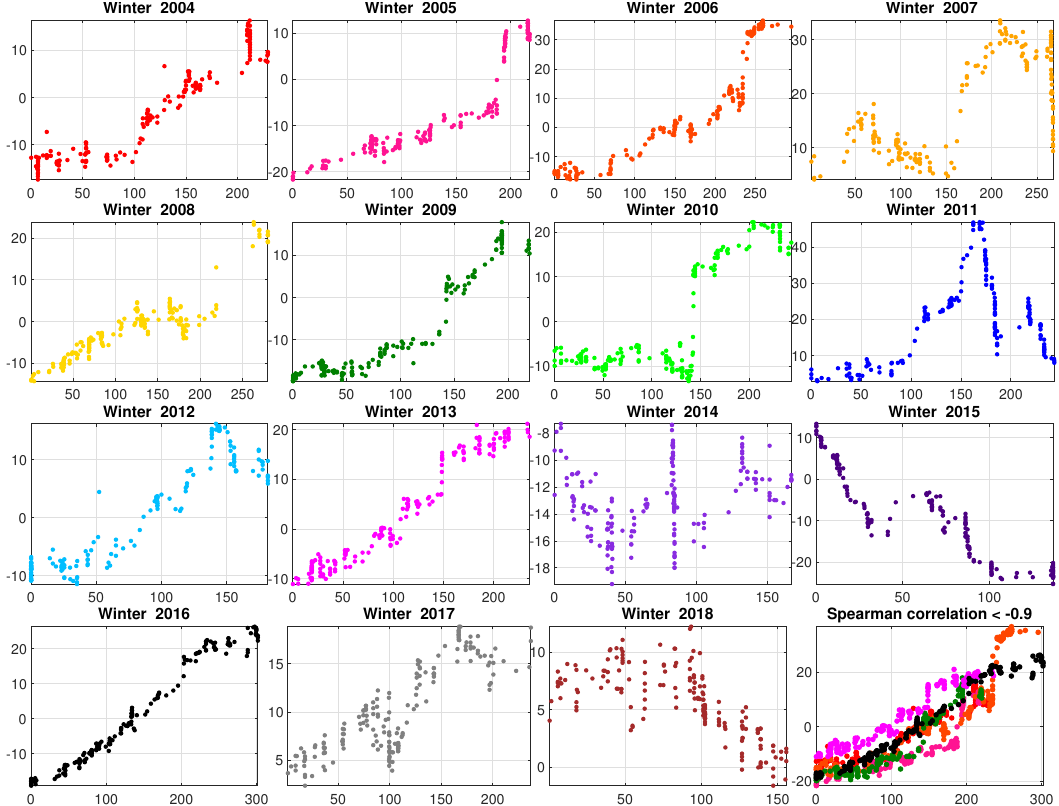
Figure 21. Scatterplots for the winter seasons. On the OY axis, the detrended groundwater levels and on the OX axis the cumulative sums of precipitation are presented. The bottom right plot presents the winter season with the highest correlation: 2005, 2006, 2009, 2013,